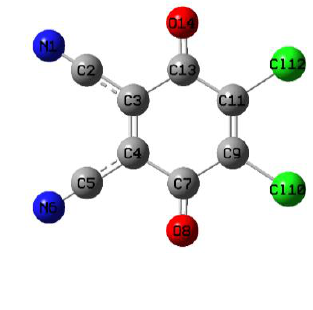
Figure 4. Optimized structures of KT, DDQ, and TCNQ.